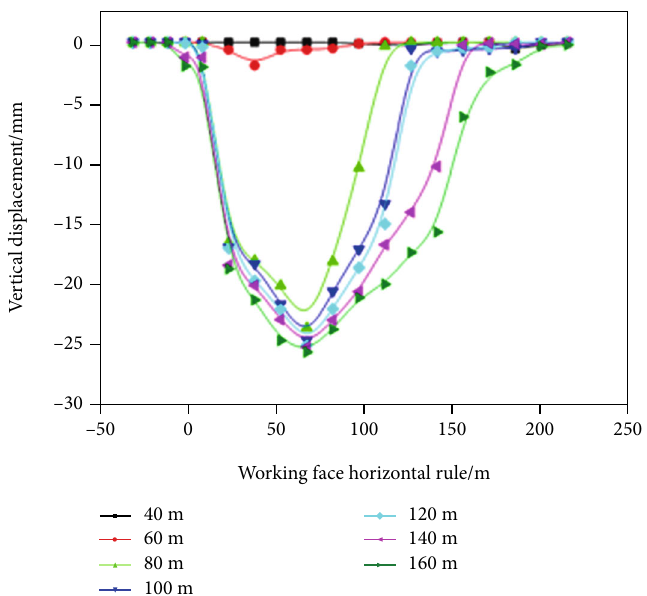
Figure 7: Dynamic subsidence curve of No. 2 line in the process of 600m deep mining depth.